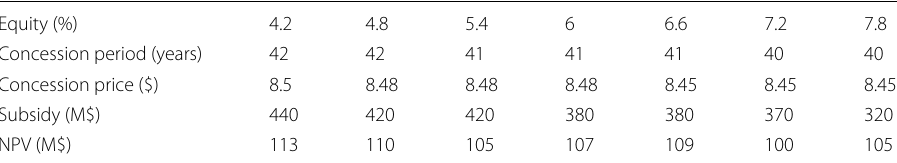
Table 7 Effects of changing the concession equity on the other concession parameters Equity